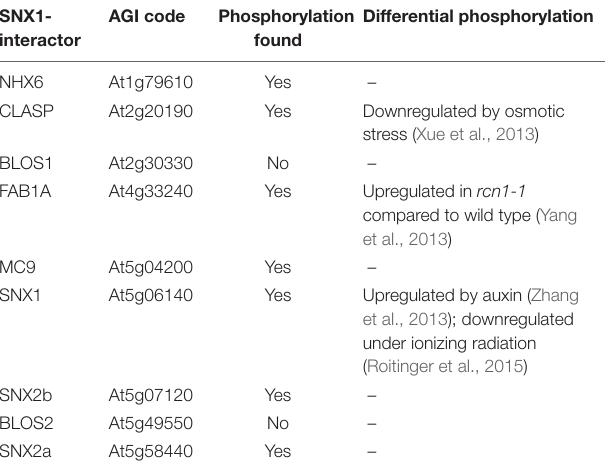
TABLE 1 | Differential phosphorylation of SNX1-interacting